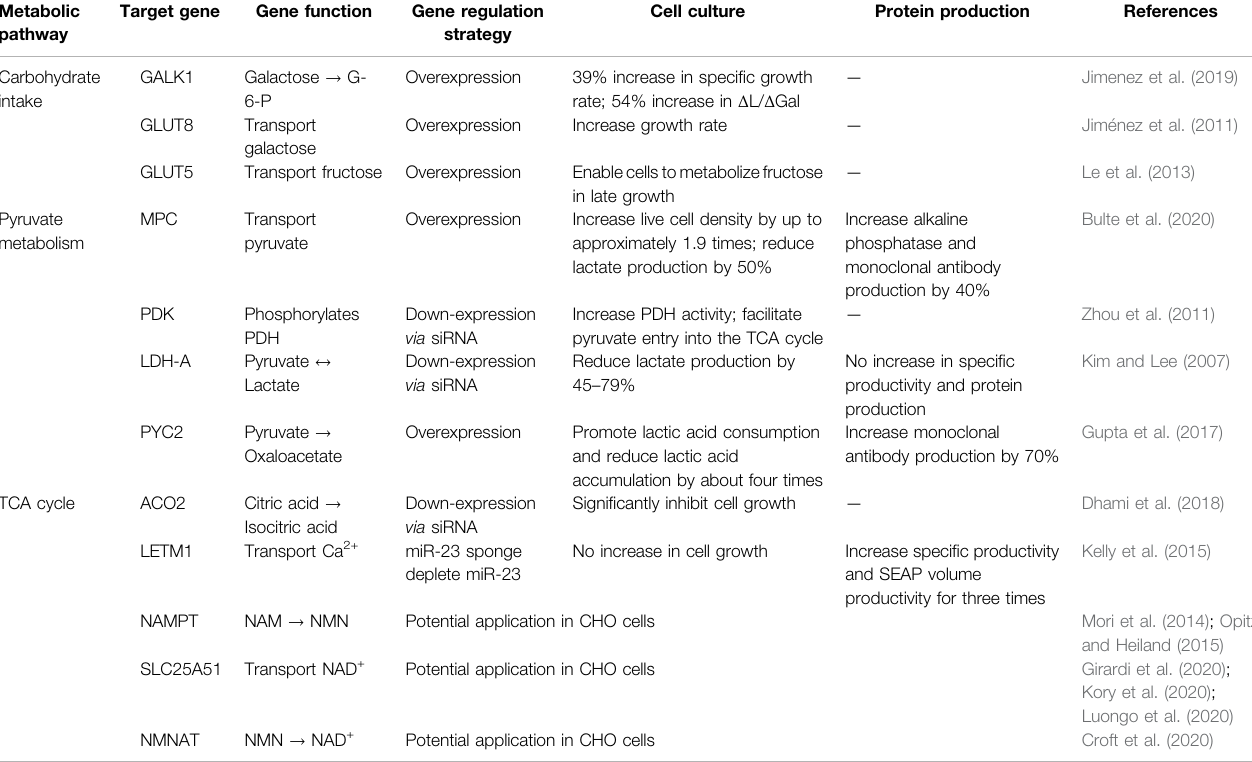
TABLE 1 | The effects of glycometabolism engineering methods on CHO cells. Metabolic